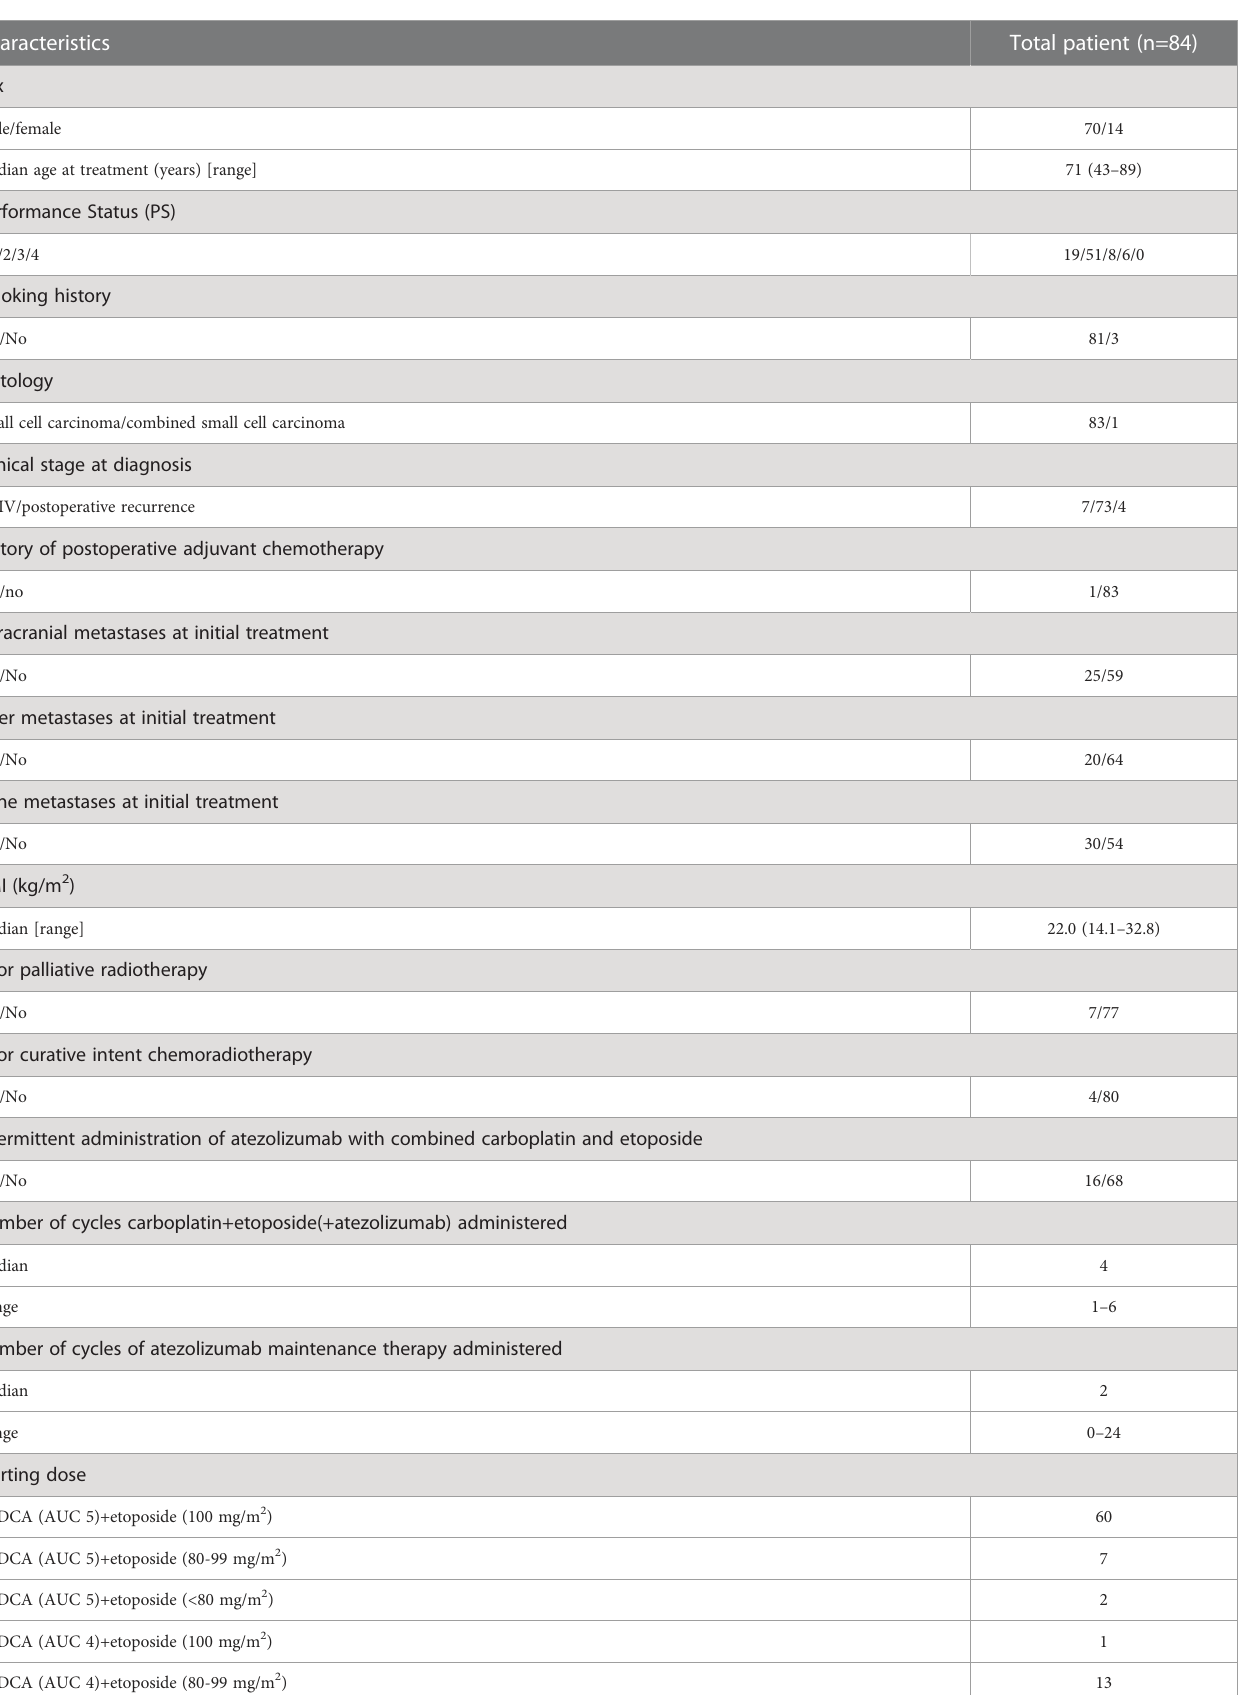
TABLE 1 Patient